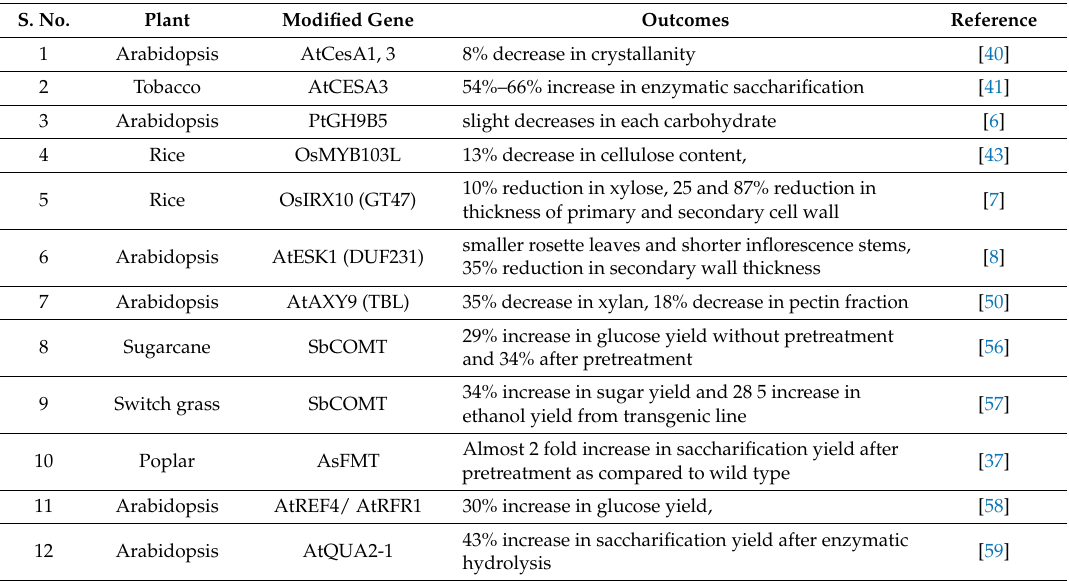
Table 3. Quantitative outcomes obtained after genetic